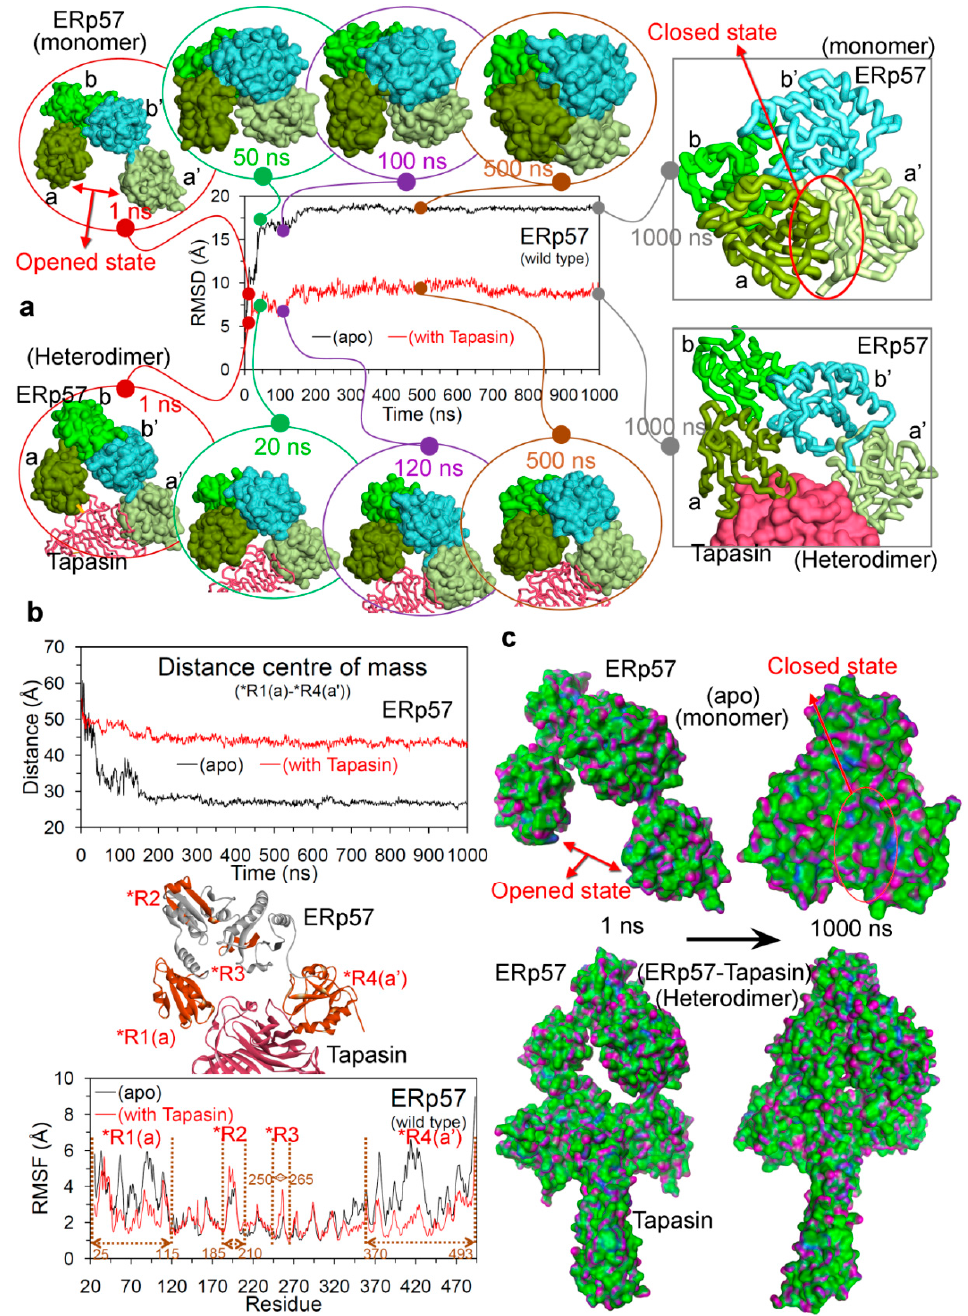
Figure 3. Structural analysis of the wild-type ERp57 from molecular dynamics (MD) simulations. ( a ) Root-mean-square deviation (RMSD) of all-atoms (excluding hydrogen atoms) of ERp57 in apo state and complexed with tapasin. Domain motion modes of ERp57 structure at di ff erent time intervals represented the dominant motions of a and a’ domains in the opened and closed conformation / state. ( b ) Distances between the centre of masses of the a and a’ domains of ERp57 and the residual fluctuations (RMSF; root-mean-square fluctuation) of each residue. ( c ) Structure conformations showing the switch of apo ERp57 from open to closed state, and ERp57 in complex with tapasin in its native conformation throughout the 1000 ns MD simulations (colour scheme: green colour for the hydrophobic regions, blue for mildly polar regions (e.g., the hydrogens of benzene) and purple for the hydrogen bonding